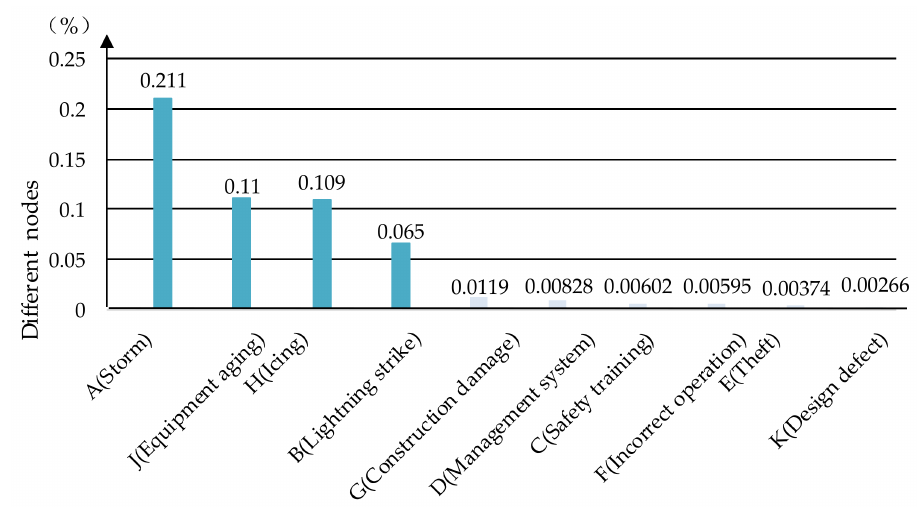
Figure 14. Sensitivity value of nodes for “Single-phase